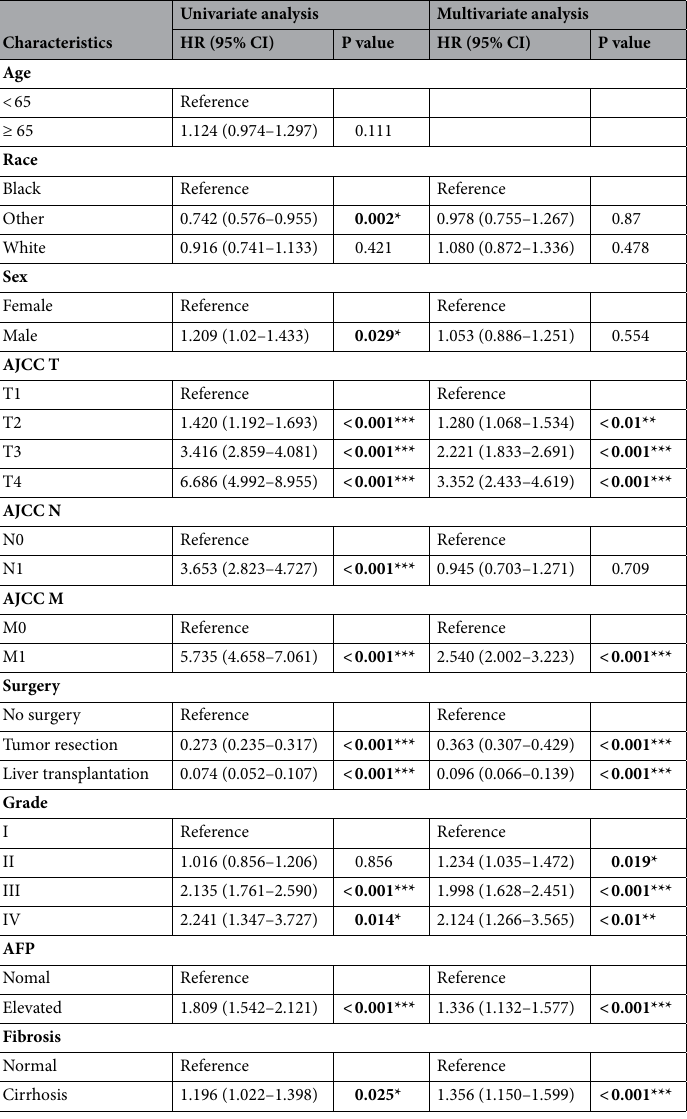
Table 2. Univariate and multivariate Cox regression analysis based on all variables for HCC patient cancer- specific survival (training